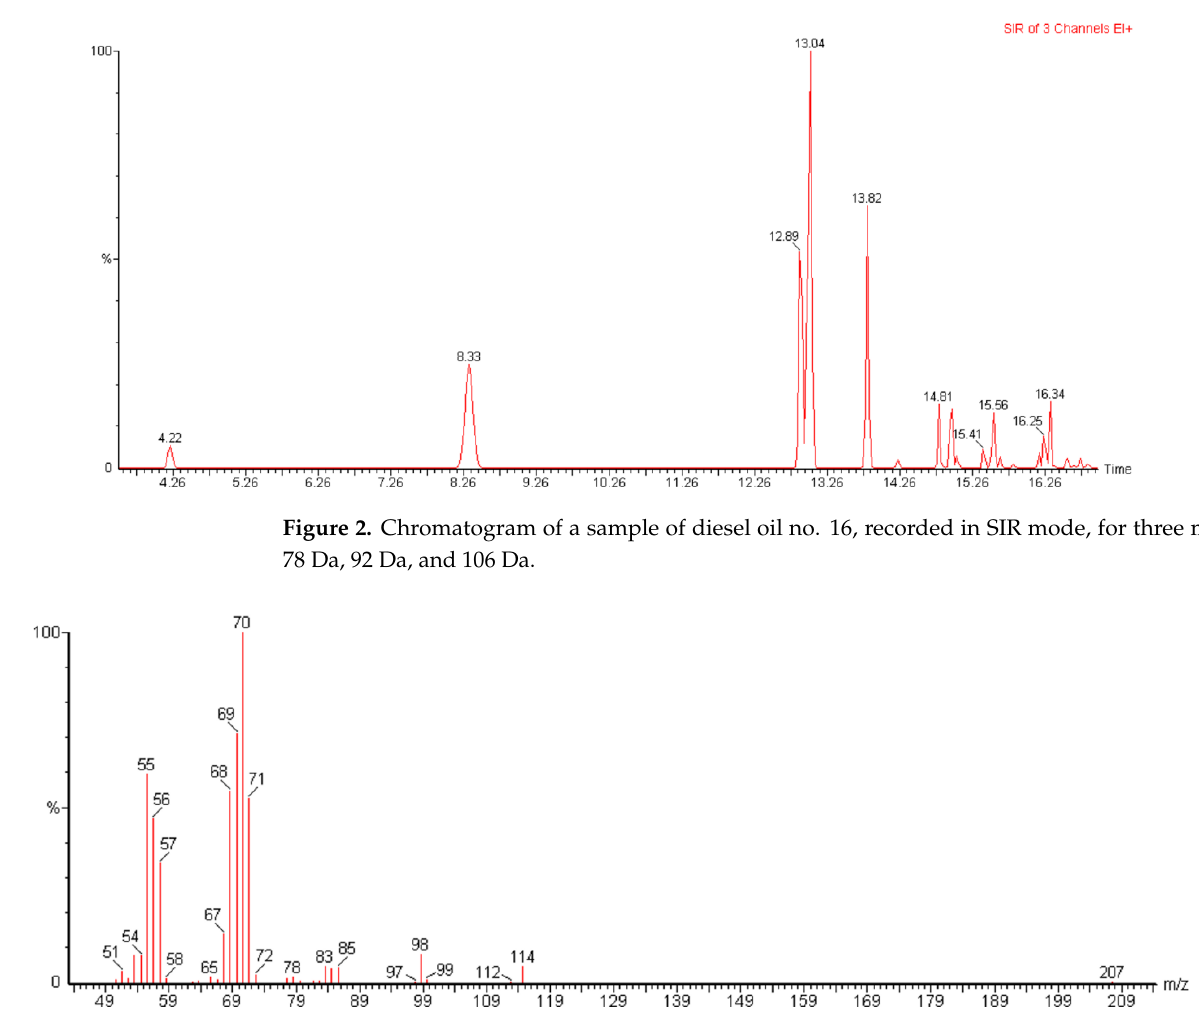
Figure 3. MS spectrum for the peak with a retention time of 4.15 min.